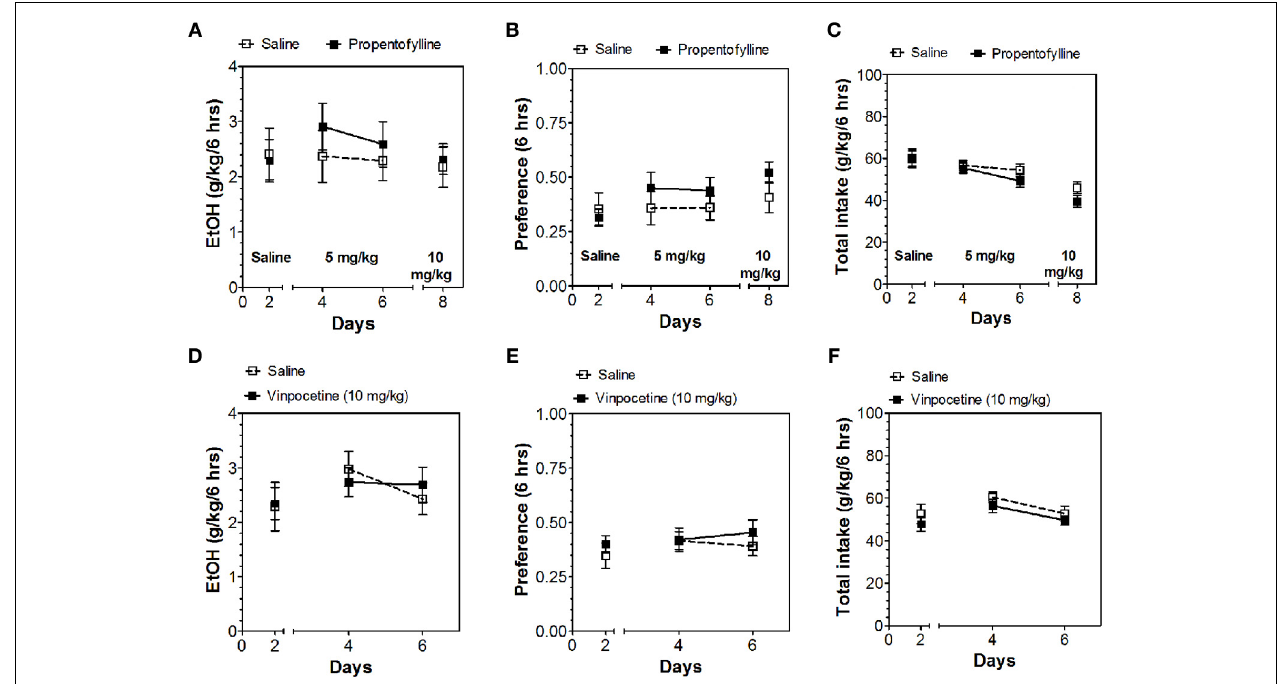
FIGURE 4 | PDE1 inhibitor vinpocetine and nonspecific inhibitor propentofylline do not alter alcohol intake during the first 6h of the 24-h two-bottle choice paradigm. Ethanol consumption is presented as g/kg/6h: (A) Propentofylline (D) Vinpocetine. Preference for ethanol: (B)